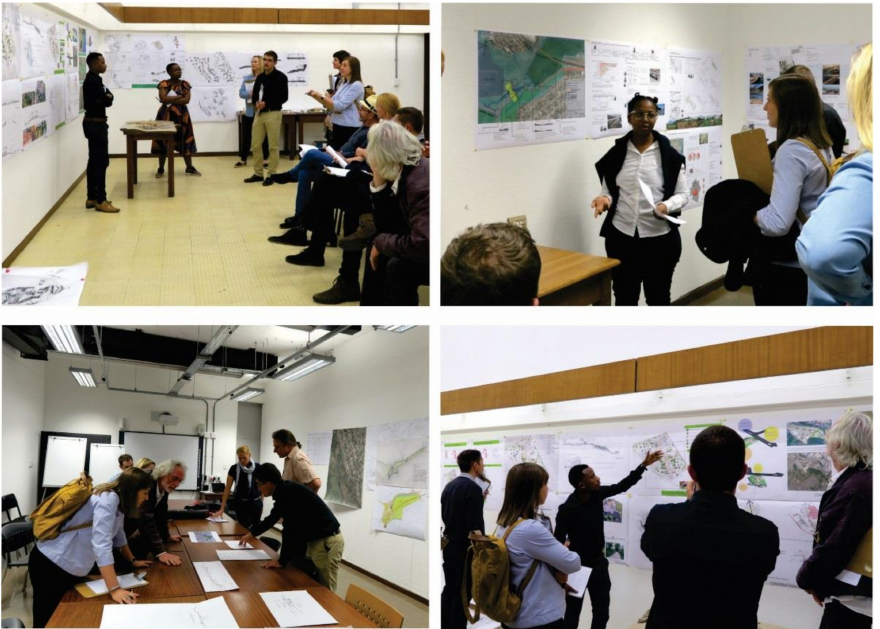
Figure 8. Students, questioned by external examiners, defend their design proposals on the Piesang’s River Park in the presence of the lecturer and municipal staff during the final examination for the quarter-year project. Source: Author, 2019.